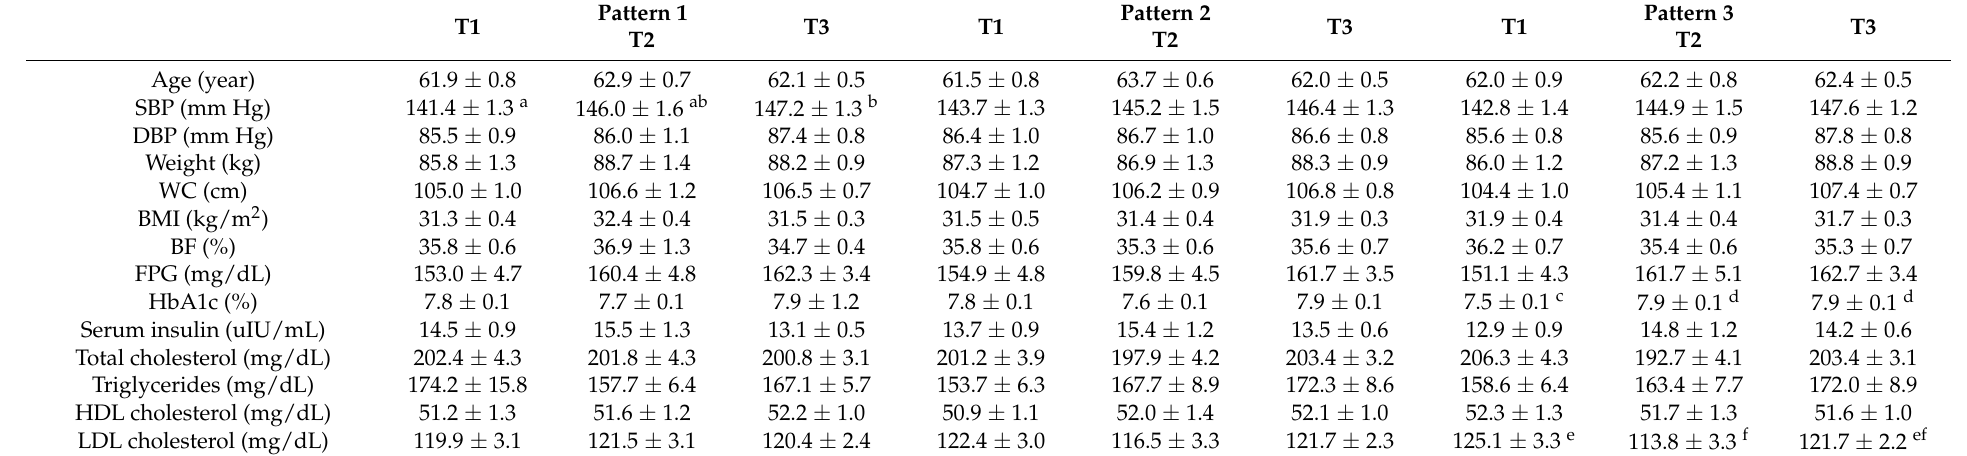
Table 5. General characteristics, anthropometric measurements and biomarkers of T2DM patients across tertiles of dietary